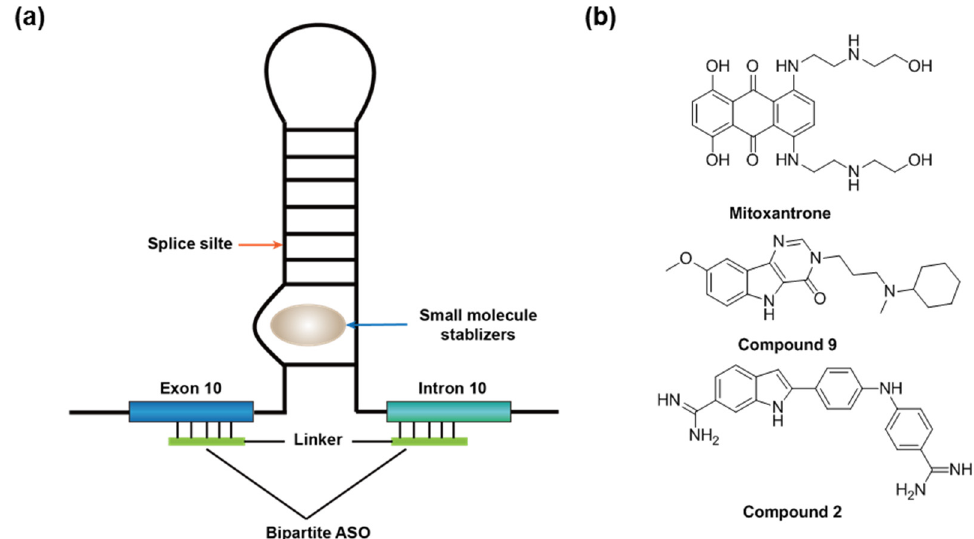
Figure 8. ( a ) A stem-loop controls the exon 10 splicing in the MAPT gene and the binding site of the known splicing modifiers. ( b ) The structures of known RNA-targeting small-molecule splicing modifiers for MAPT exon 10.